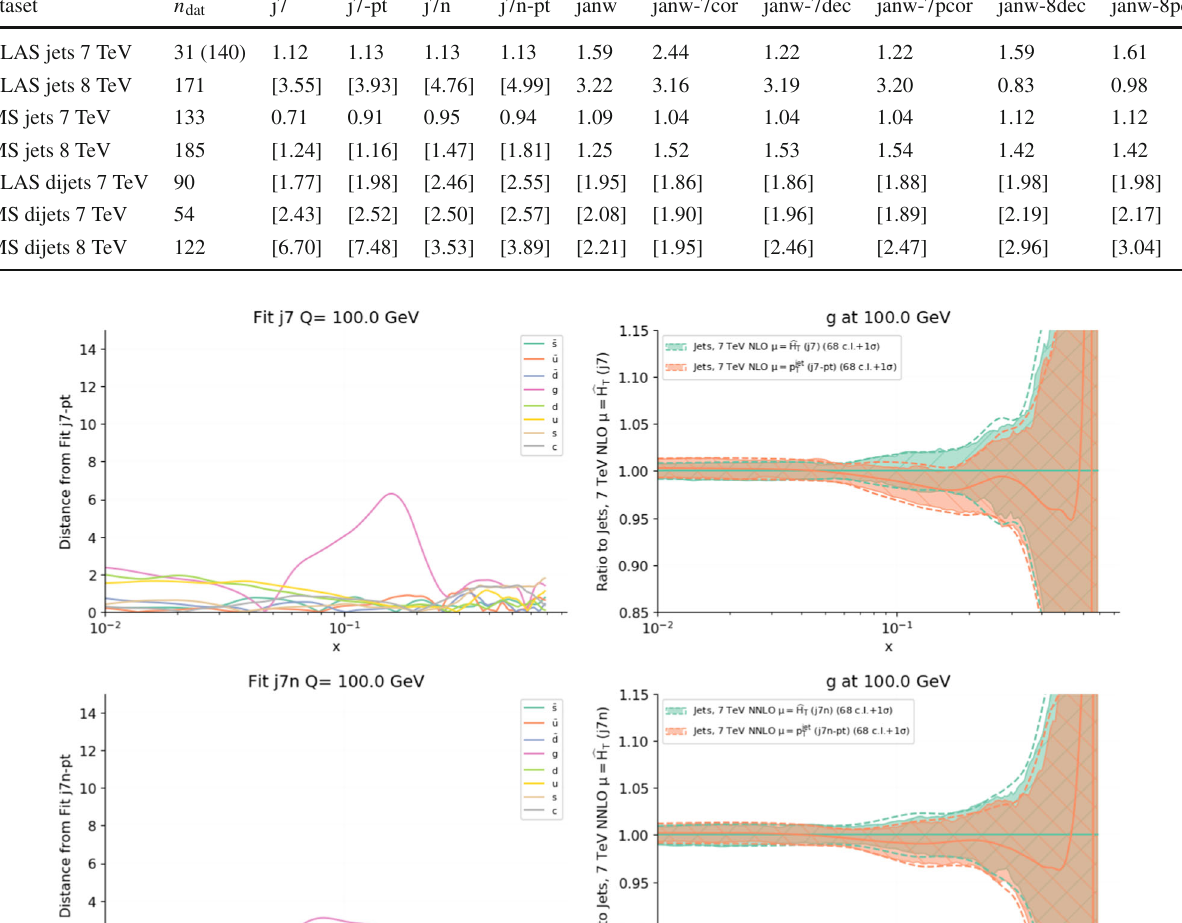
Table 5 Same as Table 3 for fits performed with alternative choices of central scale or alternative decorrelation models. Now only χ 2 val- ues for jet data are shown. Results for the fits with default settings #j7, #j7n and #janw, already shown in Table 3 are included for ease of ref-